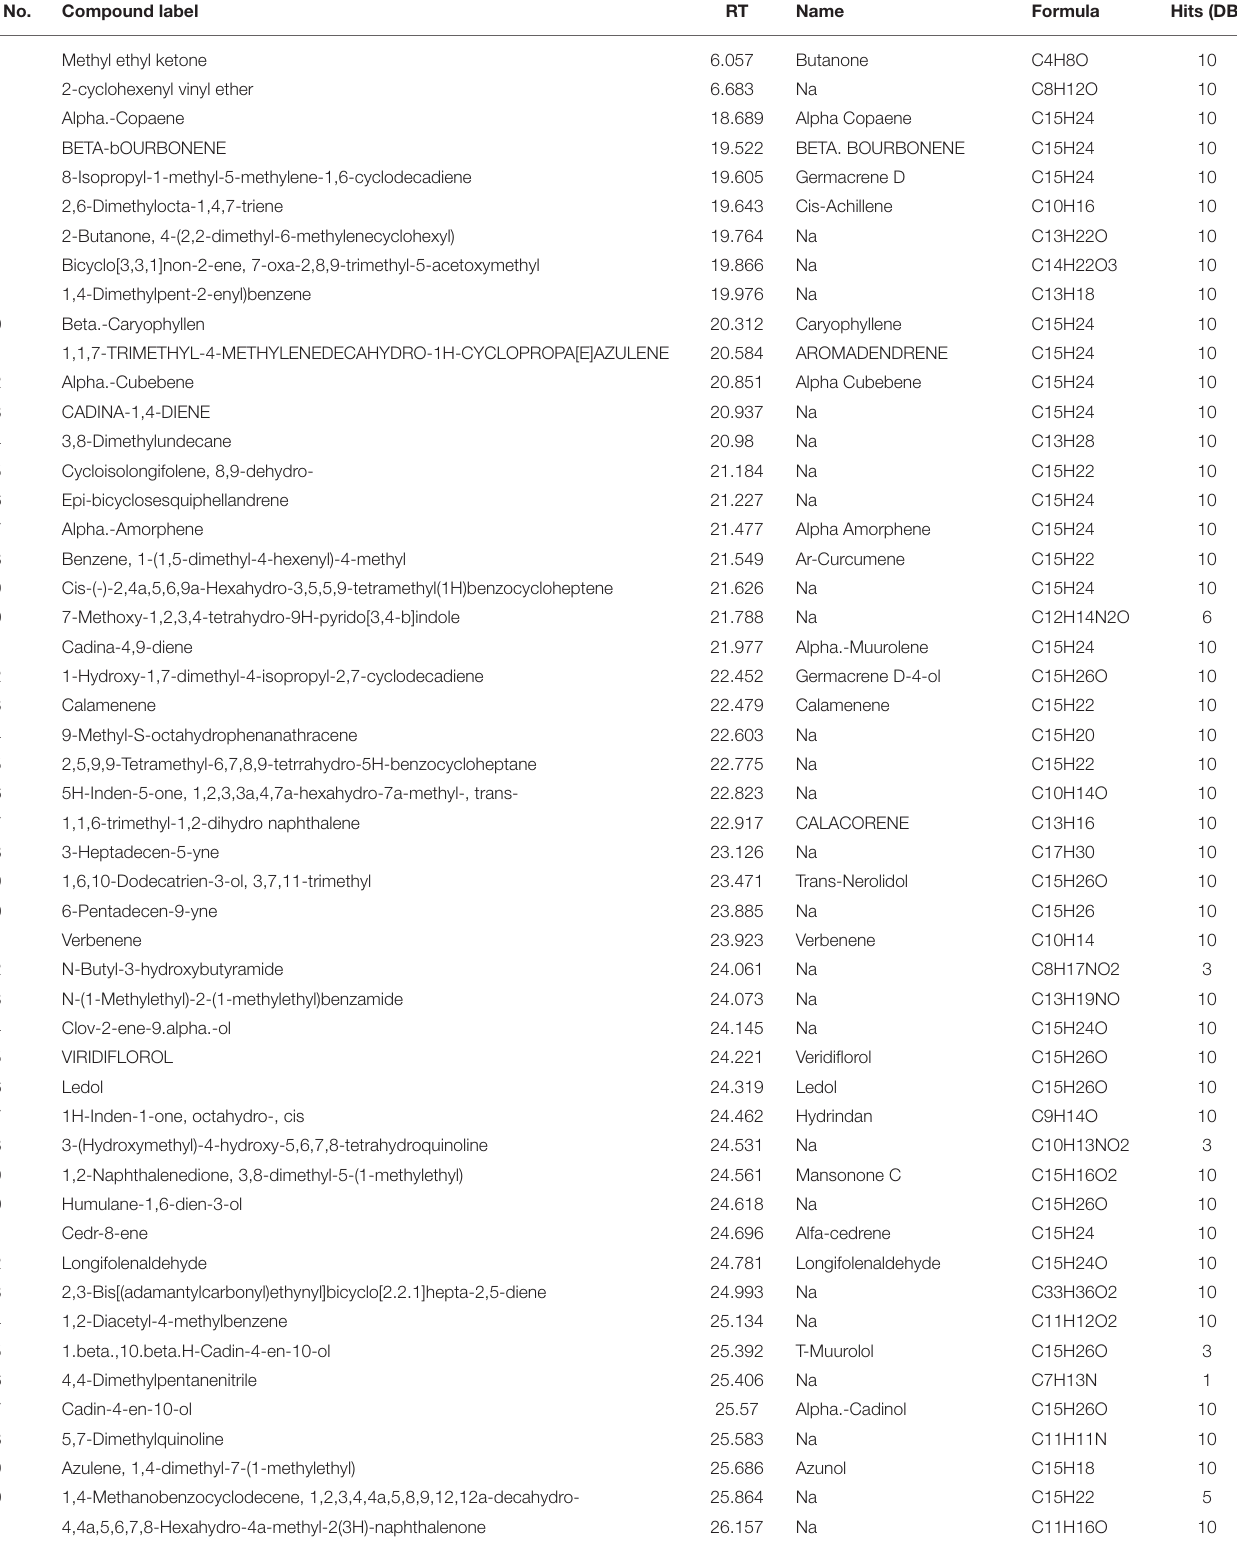
TABLE 1 | List of all the compounds identified in the GC-MS analysis of essential oil of Isodon rugosus . S.